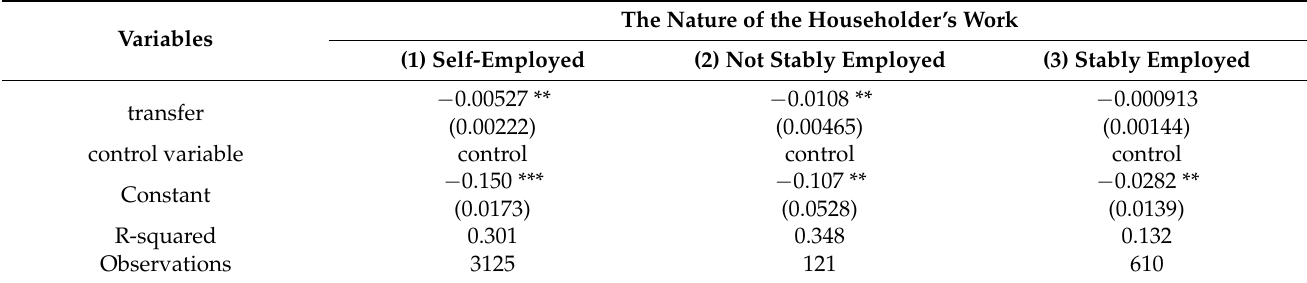
Table 5. Regression results grouped by the nature of work of the household